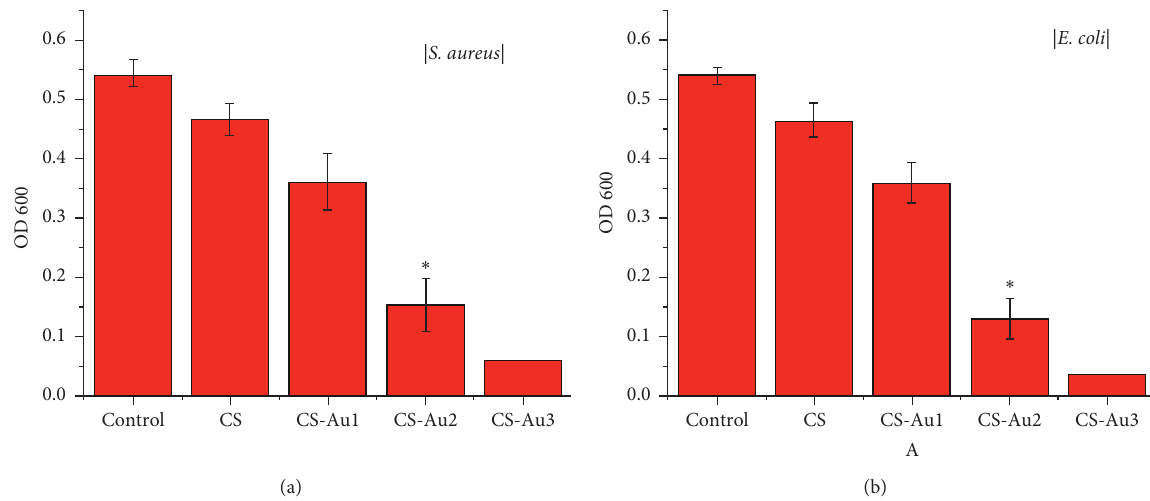
Figure 4: Average OD at 600nm (OD600) of CS, CS/AuNPs 1 (2mg/mL), CS/AuNPs 2 (5mg/mL), and CS/AuNPs 3 (10mg/mL) against S. aureus (a) and E. coli (b) Error bars represent the mean ± SD ( n � 3; ∗ statistically significant difference, ∗ P < 0 .